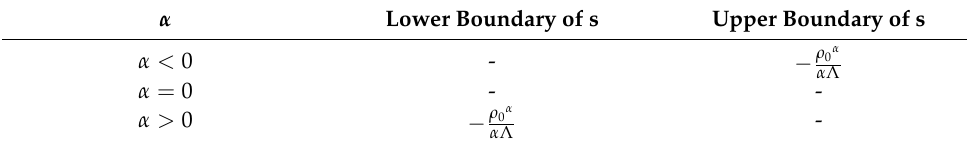
Table 1. The lower boundary and upper boundary of s